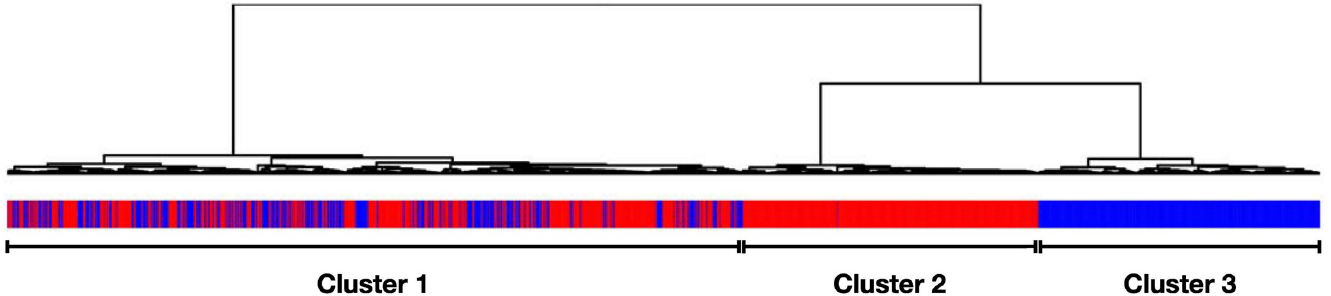
Fig 2. Dendrogram of clustering results based on differentially expressed genes. Custom annotation illustrates the actual sample classification. Hierarchical clustering based on derived expression data identifies three main sub-groups (from left to right), with the first cluster containing both samples with sepsis patients (red) and non-sepsis samples (blue), a second cluster almost entirely comprising sepsis (red), and a third cluster exclusive to non-sepsis samples (blue).